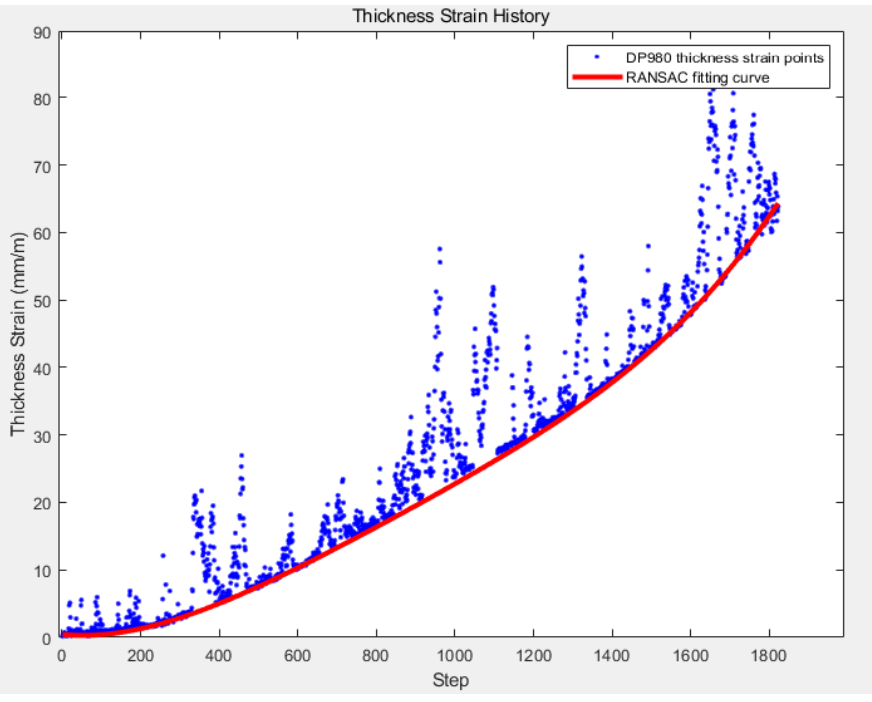
Figure 7. Fitting curve by RANSAC algorithm.